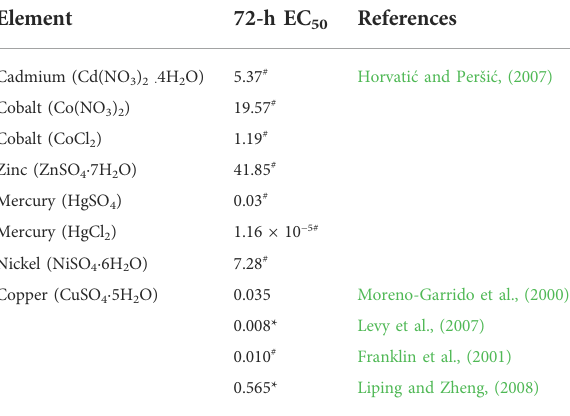
TABLE 4 Toxicity response of P. tricornutum to metals in 72-h growth inhibition bioassays. *Measured, #Nominal Concentrations.